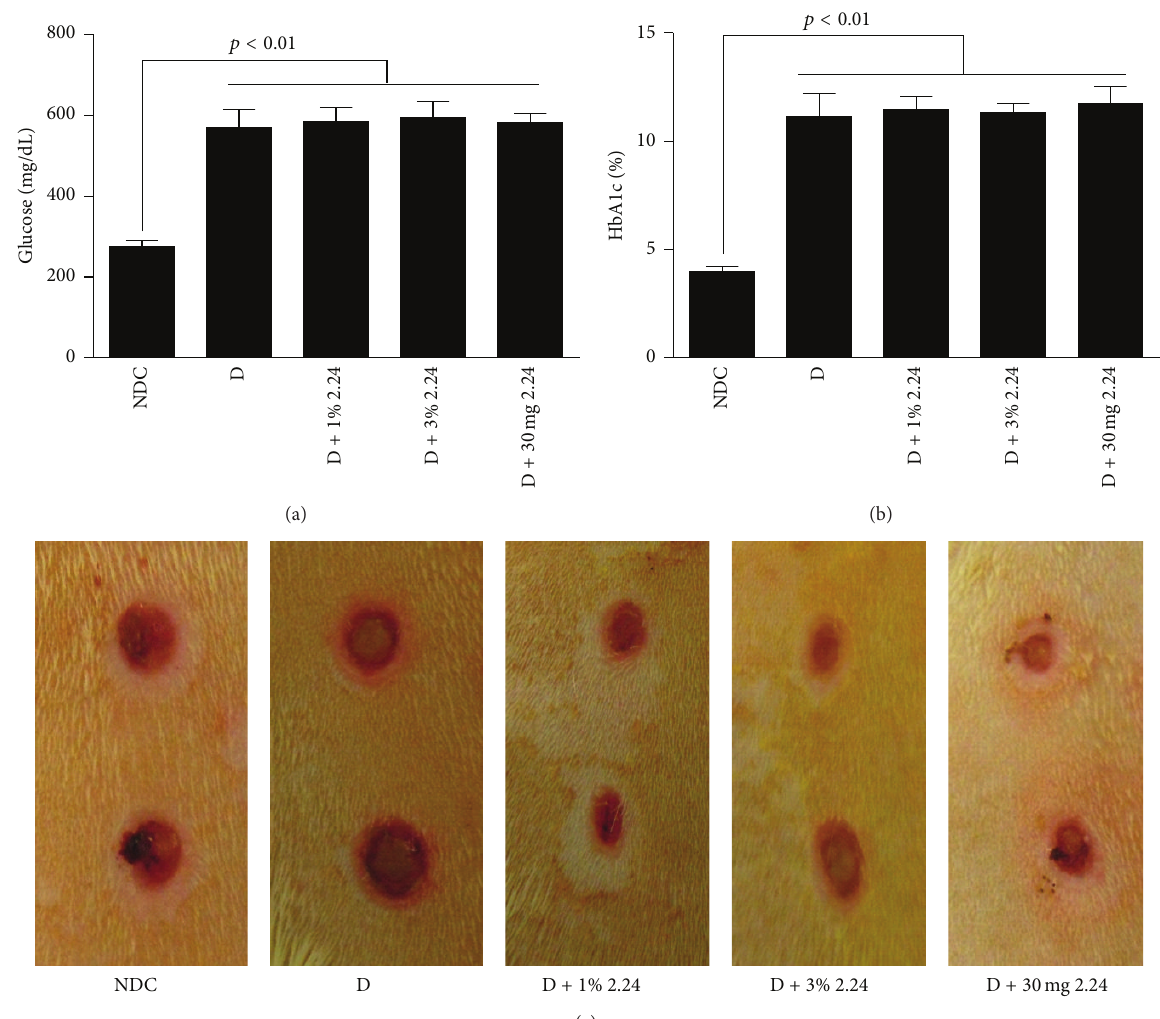
Figure 1: (a) Blood glucose and (b) HbA1c levels in the serum of normal (NDC) and diabetic (D) rats 4 weeks after STZ injection. The D rats were treated either by topical administration with vehicle (white petrolatum jelly) alone, or with a 1% or 3% suspension of CMC2.24 (D + 1% 2.24 or D + 3% 2.24, resp.), or by oral intubation with 30 mg/kg CMC2.24 suspended in 2% carboxymethylcellulose (D + 30 mg 2.24). The topical and systemic CMC2.24 treatments were administered daily during the final 7 days of the protocol, 3 weeks after inducing diabetes. Each value is the mean ± standard error of mean (SEM) of 3 rats per group. (c) The typical clinical appearance of the skin wounds from each of the five experimental groups 7 days after initiating the daily topical and systemic treatments. A 𝑝 value ≤ 0.05 was considered statistically